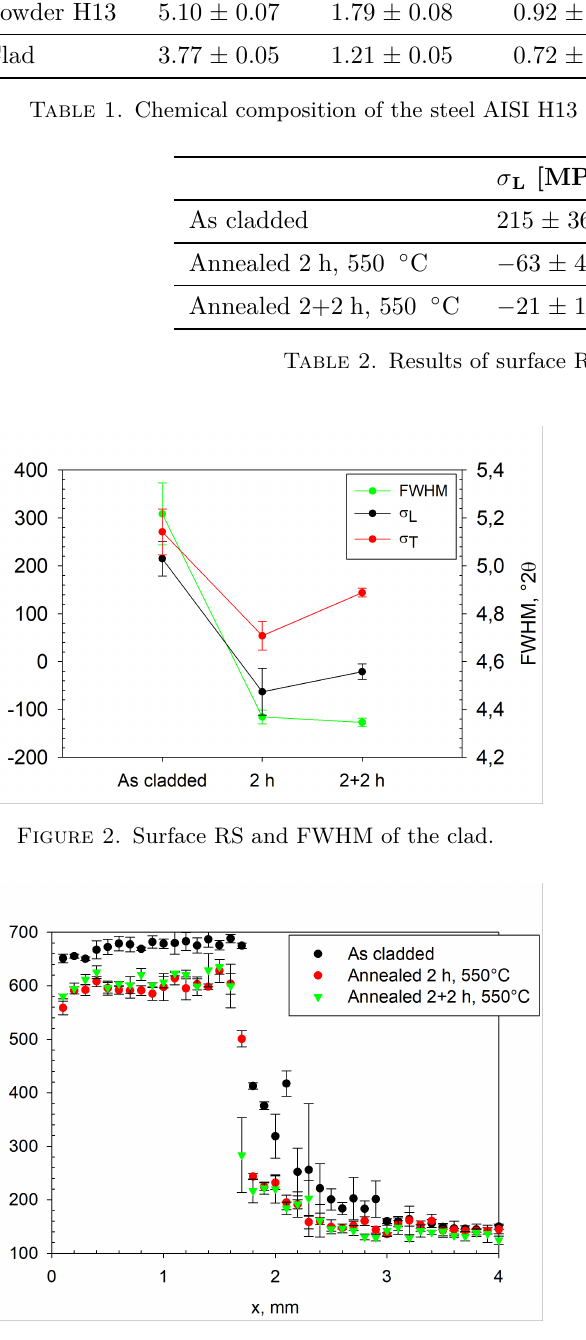
Figure 3. Depth gradient of hardness, where x is distance from the surface of the clad.